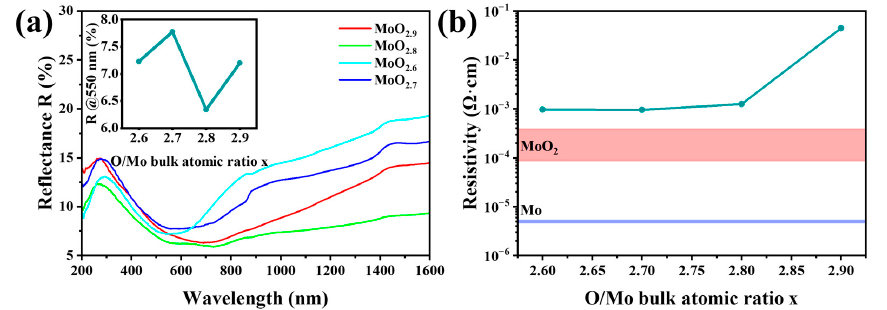
Figure 12. Reflectivity ( a ) and resistivity ( b ) of the MoO x ceramics. The resistivity also includes the reference values of metal Mo and MoO 2 in the literature [36].